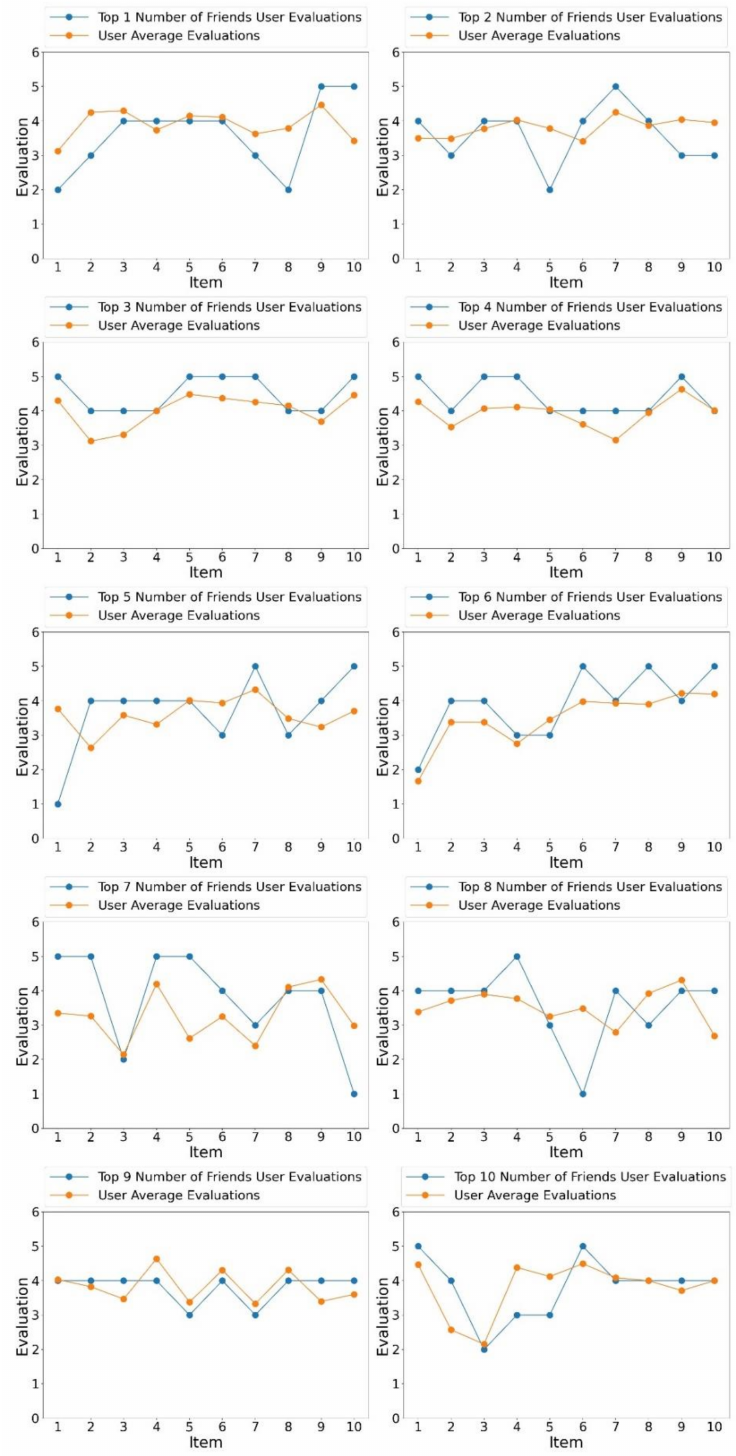
Figure 7. Comparison of the evaluations by the top 10 users with a large number of friends with the average evaluations by all